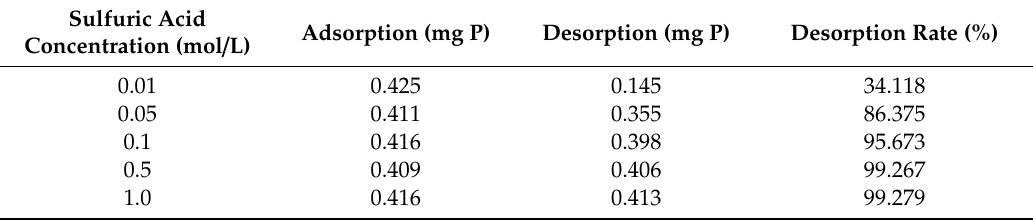
Table 8. Desorption of ZSFB composite fiber in sulfuric acid